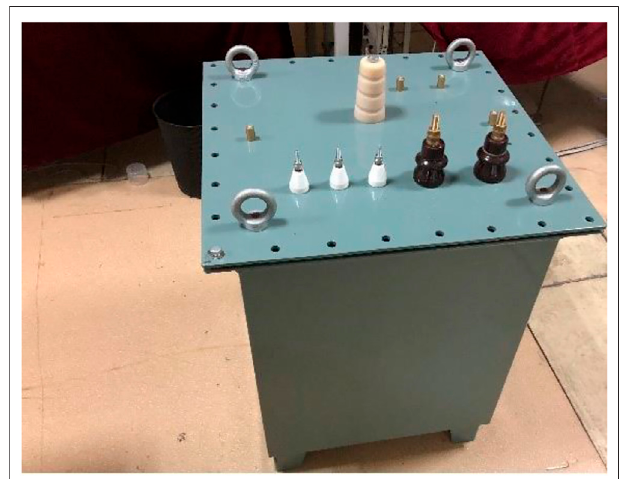
FIGURE 1 | Oil-immersed transformer model.